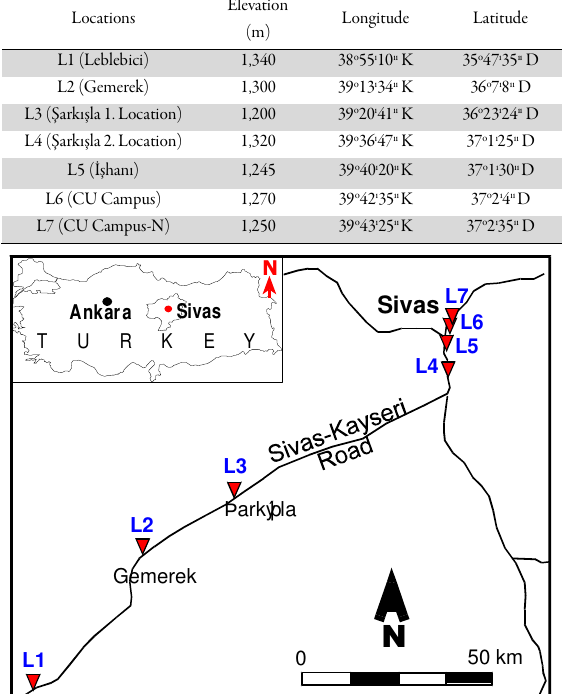
Table 1. The locations of the plant and soil samples Locations